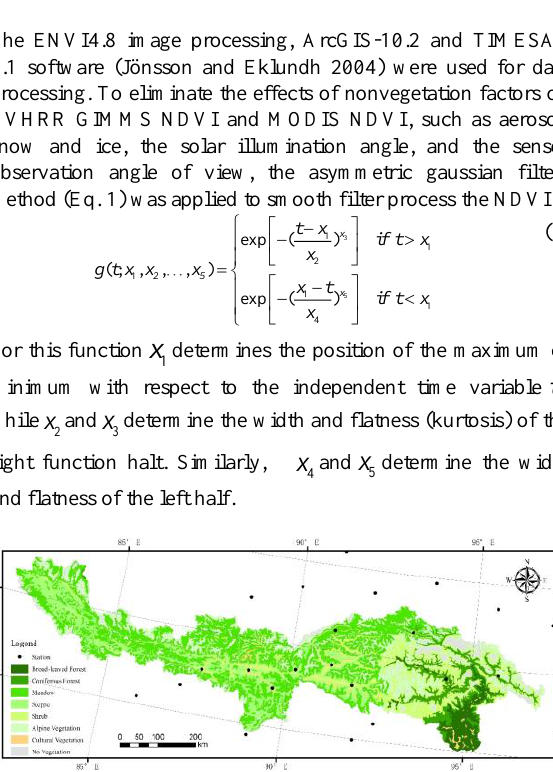
Figure 2. Vegetation types and meteorological stations in the Yarlung Zangbo River basin